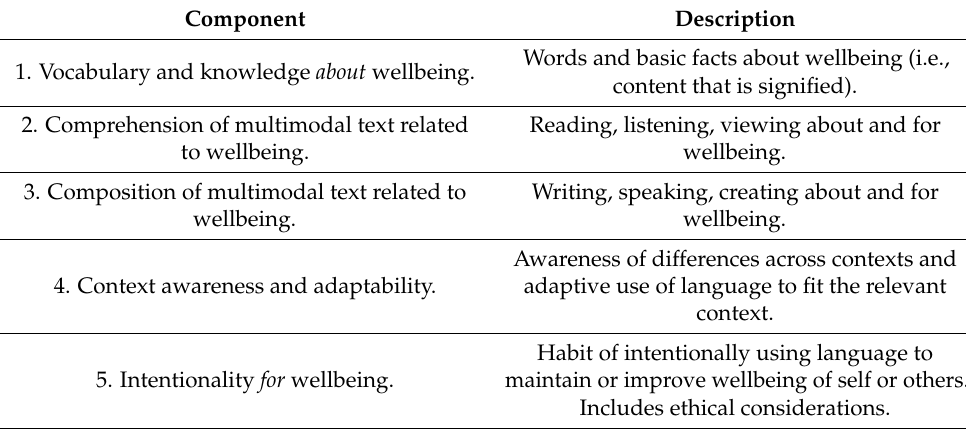
Table 1. Five-component model of wellbeing